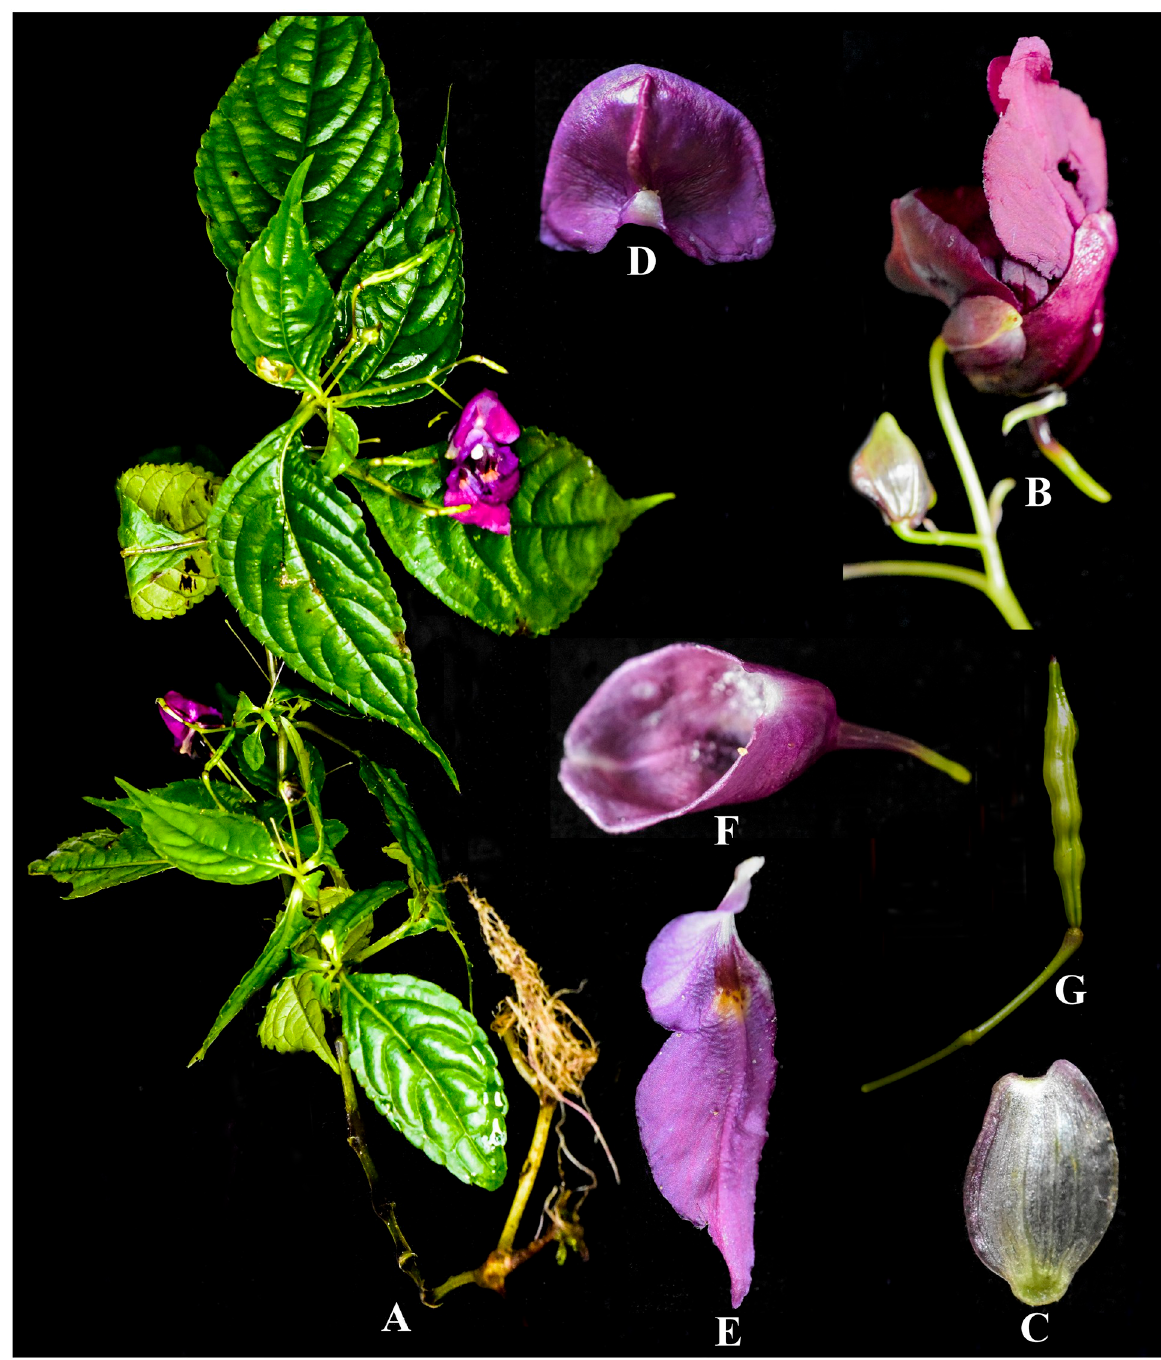
Fig 14. Impatiens gorepaniensis A. Flowering plant; B. Flower (side view); C. Lateral sepal; D. Dorsal sepal; E. Lateral united petal; F. Lower sepal; G. Capsule. Photographs by Bhakta Bahadur Raskoti.